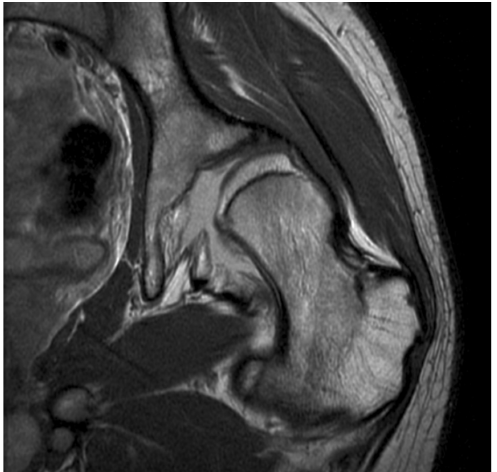
Figure 7. Radiographic features of Stage 4 MSP at the hip: MRI scan of a 14-year old boy, Type IV, left hemiplegia, chronic neglected hip displacement, GMFCS III. Note the full thickness loss of articular cartilage on the lateral aspect of the femoral head. The left hip was successfully reconstructed, but this is salvage surgery. The lost cartilage does not regenerate, and the hip is destined for premature arthrosis and